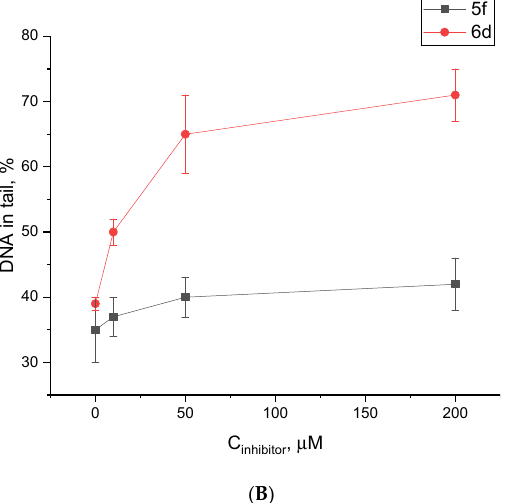
Figure 2. The influence of compounds 5f and 6d on the accumulation of DNA damage induced by topotecan. ( A ) The images of cells treated with combination of topotecan and leader compounds in different concentrations. ( B ) The dependence of tail DNA on Tdp1 inhibitor concentration. The dose-dependent increase of % tail DNA with 6d concentration can be observed. Error bars show SD for two independent experiments.